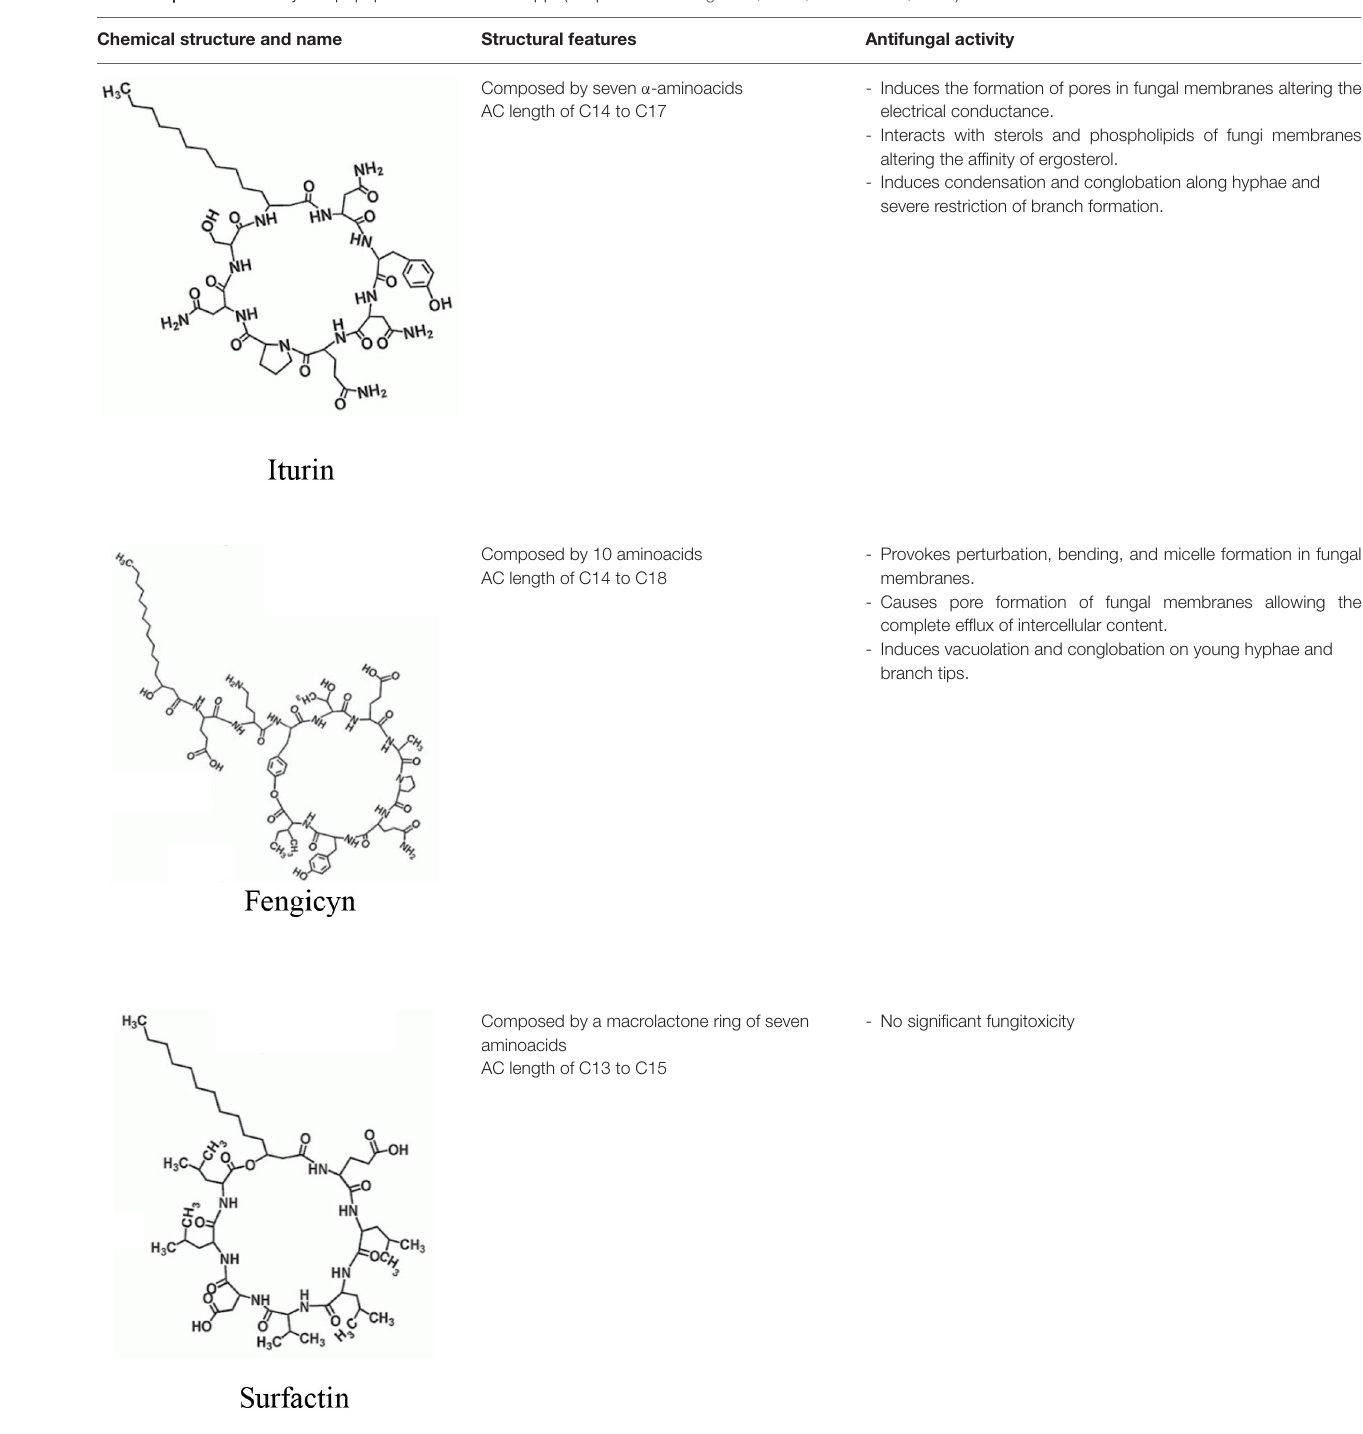
TABLE 2 | Antimicrobial cyclic lipopeptides from Bacillus spp. (adapted from Gong et al., 2015; Caulier et al.,